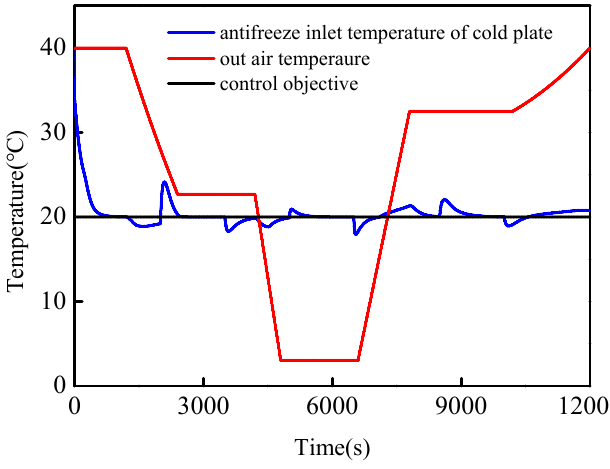
Figure 19. Antifreeze inlet temperature of cold plate during temperature variation.